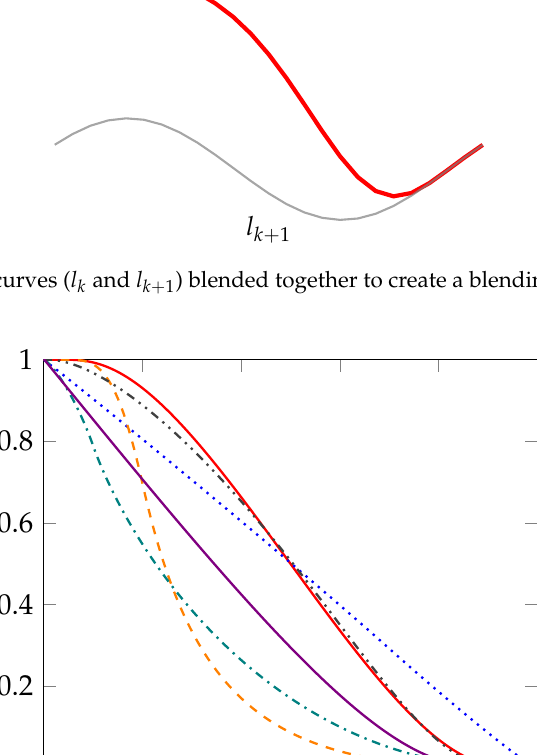
Two local curves ( l Figure 1.